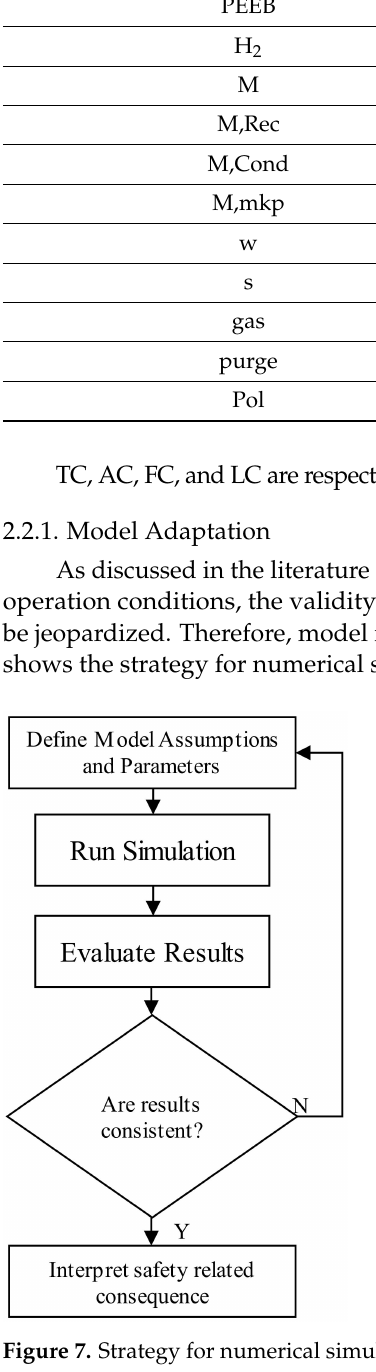
Figure 7. Strategy for numerical